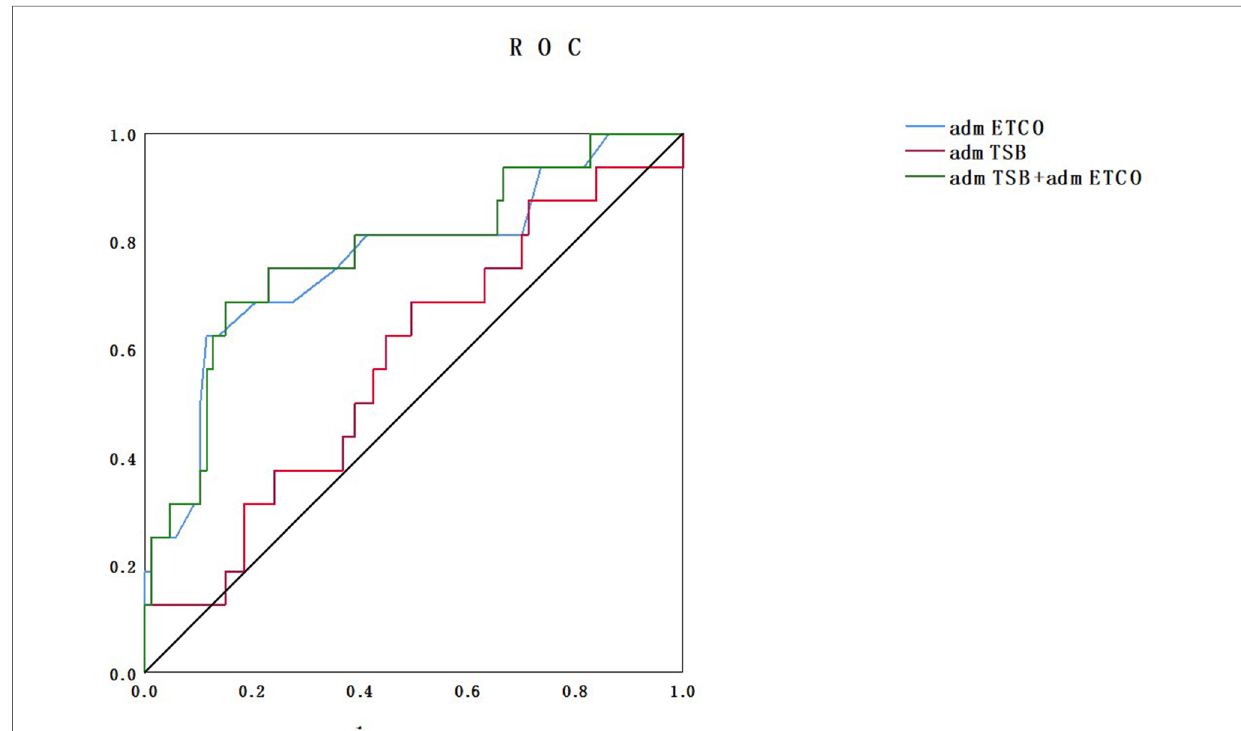
FIGURE 1 ROC curves comparing ETCOc measurements, STB measurements alone on admission, and combined ETCOc and STB measurements. ROC, receiver operating characteristic; ETCOc, end-tidal carbon monoxide corrected to ambient carbon monoxide; STB, serum total bilirubin.